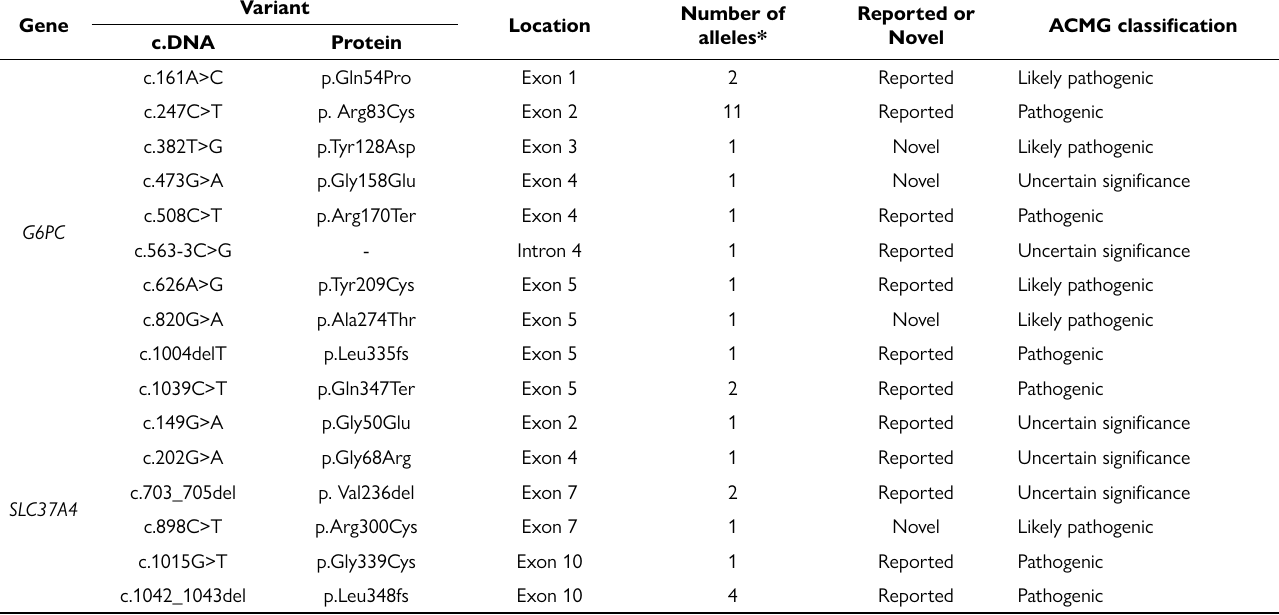
Table 3. Gene variants found in 21 patients with GSDI Gene